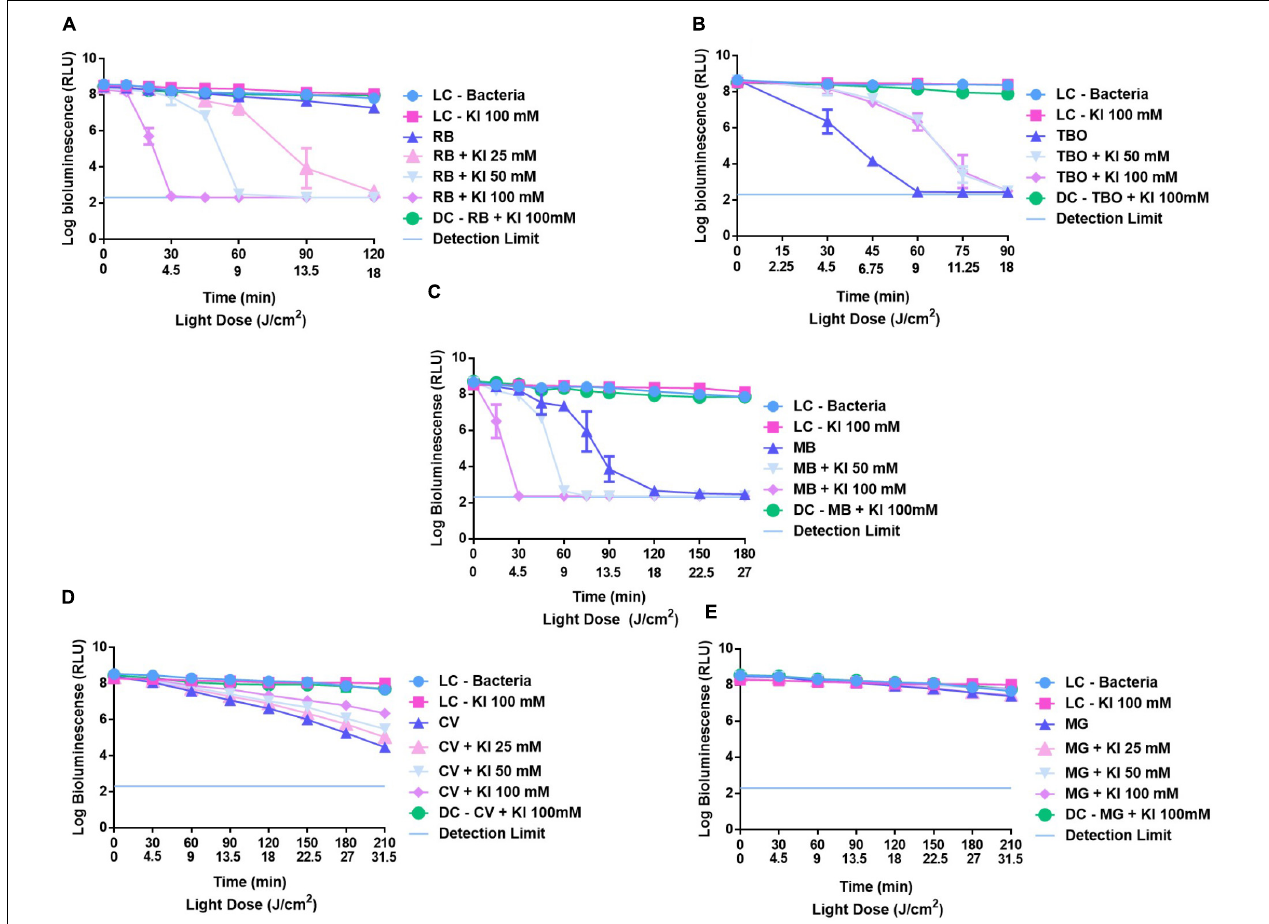
FIGURE 6 | Survival of bioluminescent E. coli during aPDT assays in the presence of non-porphyrinic PSs at 5.0 µ M RB (A) , TBO (B) , MB (C) , CV (D) , and MG (E) alone and combined with KI at 25, 50, and 100 mM. The values are expressed as the three independent experiments; error bars indicate the SD.